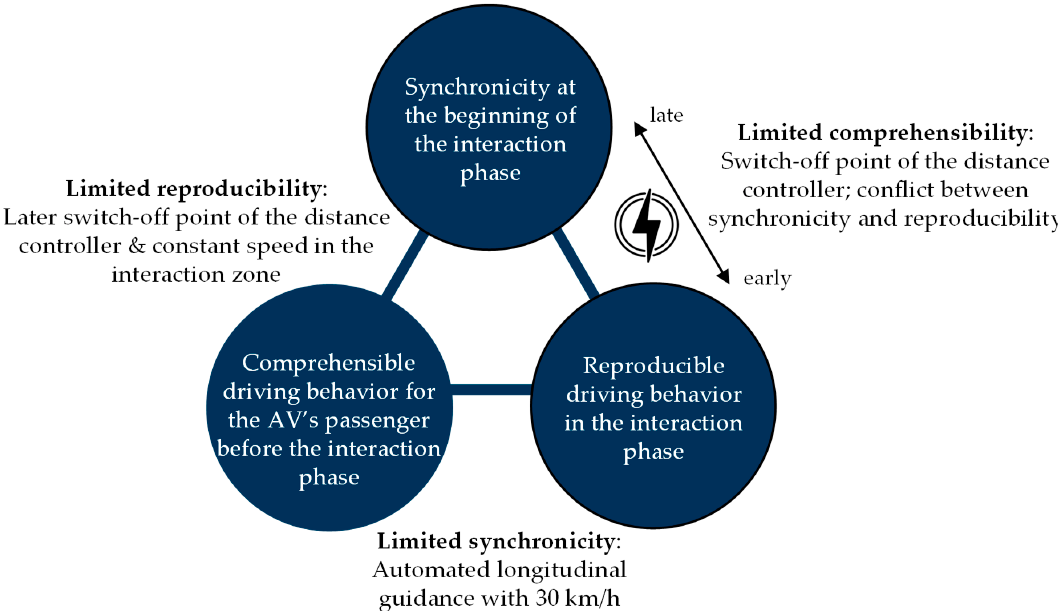
Figure 4. Effect of the switch-off point of the distance controller on the attributes synchronicity, reproducibility, and comprehensibility for detail synchronization. The switch-off point results in a trade-off between these attributes in a way that a simultaneous fulfilling of all attributes cannot be guaranteed.